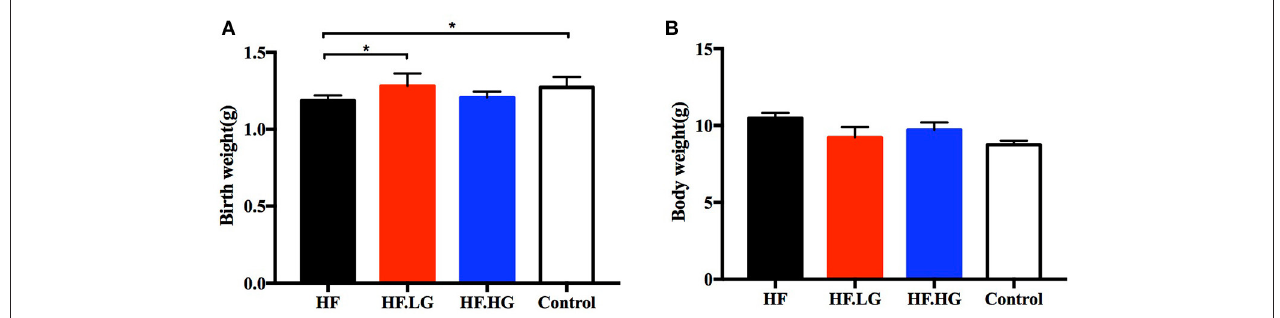
FIGURE 1 | Birth weight and body weight at weaning in offspring. (A) Birth weight, and (B) Body weight of female offspring at weaning. HF, high-fat diet without genistein; HF. LG, high-fat diet with low-dose genistein; HF. HG, high-fat diet with high-dose genistein; Control, normal control diet. Data are expressed as means ± S.E.M. ( n = 6–8/group). Mean values were significantly different between other group and the HF group: * p <